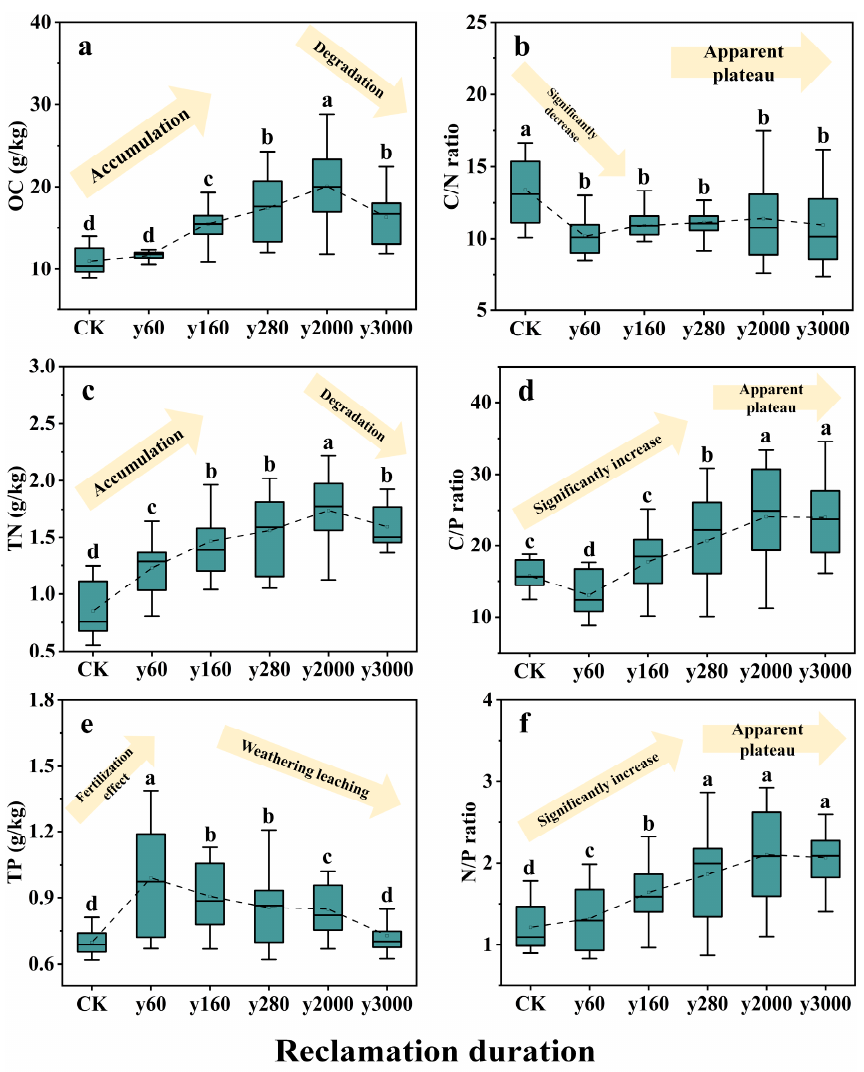
Figure 3. OC, TN, and TP contents and ratios at different stages of land reclamation. ( a ) Organic carbon; ( b ) C/N ratio; ( c ) total nitrogen; ( d ) C/P ratio; ( e ) total phosphorus; ( f ) N/P ratio. Control: fresh sediment. Lines within the boxes give the median, boxes the 25th and 75th percentile, and whiskers the lowest and highest values excluding outliers. The dotted lines are the means (square symbols) connection of each reclamation stage. Different lowercase letters indicate means are different at p < 0.05 over different reclamation stages. The yellow-shaded arrows represent our interpretation on nutrient content changes and description of the primary dynamics of